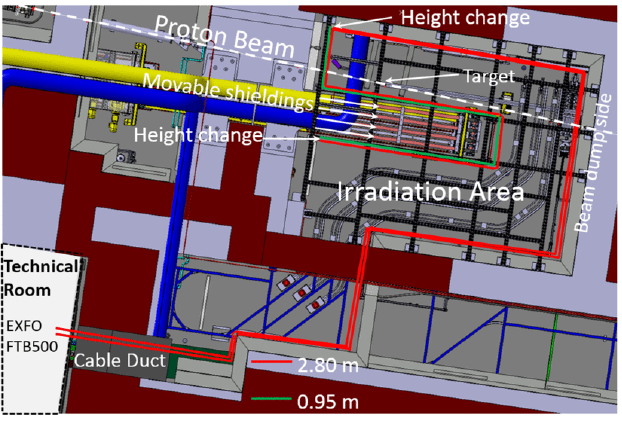
Figure 24. Distributed dosimeter in the CERN Proton Synchrotron Booster (PSB) [202].